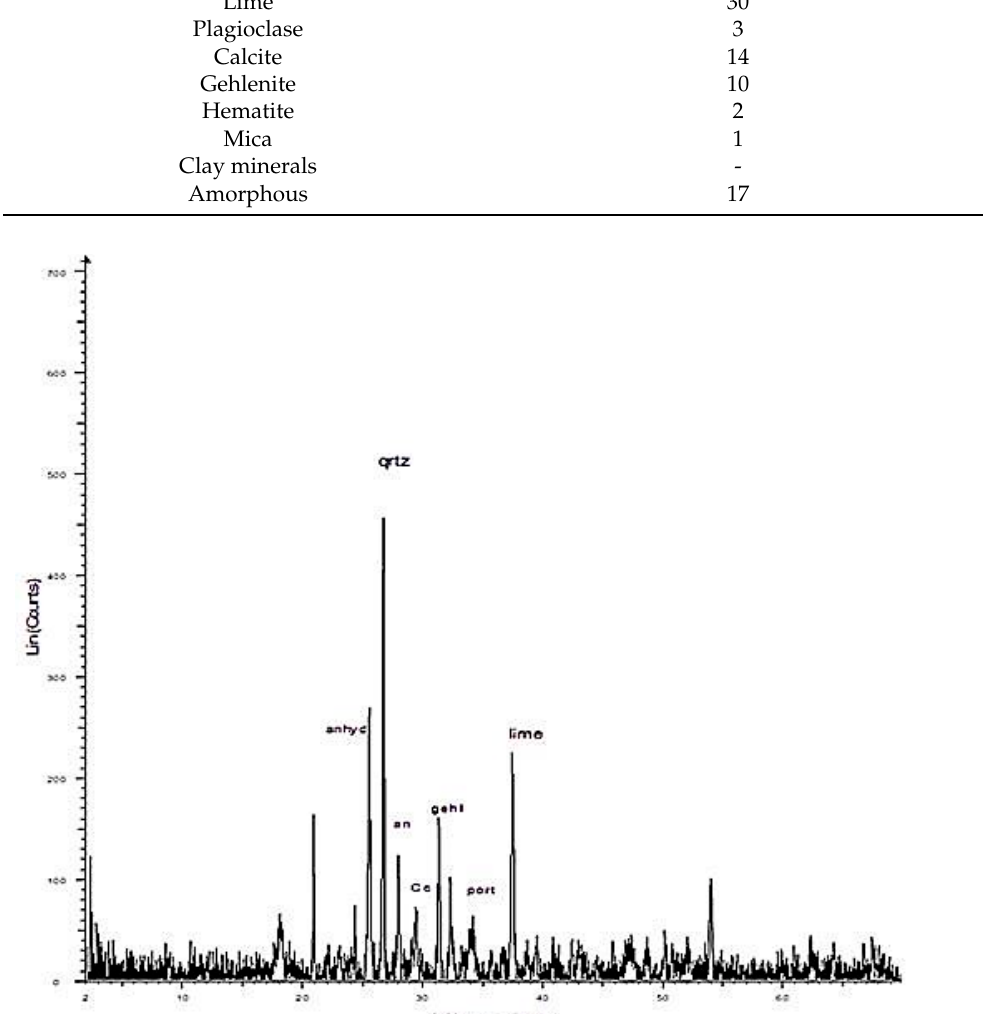
Figure 7. XRD pattern of fly ash from a Kardia power plant: Qrtz: quartz, Cc: calcite, an: anorthite, anhyd: anhydrite, gehl: gehlenite, port: portlandite, lime: lime. anhyd: anhydrite, gehl: gehlenite, port: portlandite, lime: